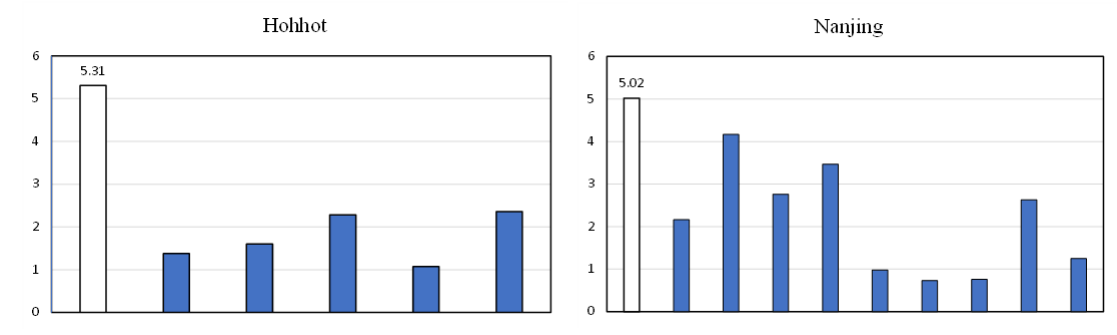
Figure 4. Ratio of post-period MSPE and pre-period MSPE.